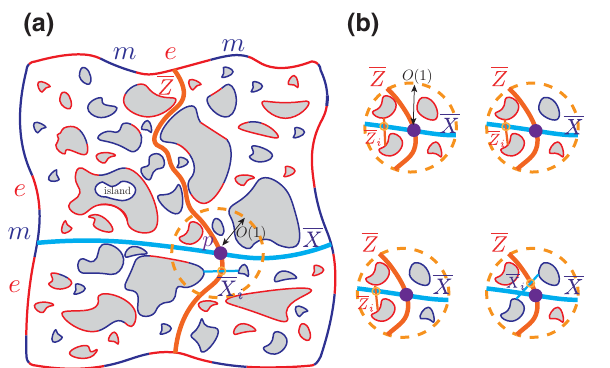
FIG. 8. An illustration for the proof of Theorem 1 with a generic random fractal embedded in R 2 . (a) The holes are col- ored in gray and, in general, have possibly alternating types of boundary. The holes can also contain “islands” (white) within them, which can simply be ignored. A pair of macroscopic logi- cal strings X and Z intersect at a single point p . (b) The different scenarios within the O ( 1 ) radius from the intersection point p with different configurations of hole